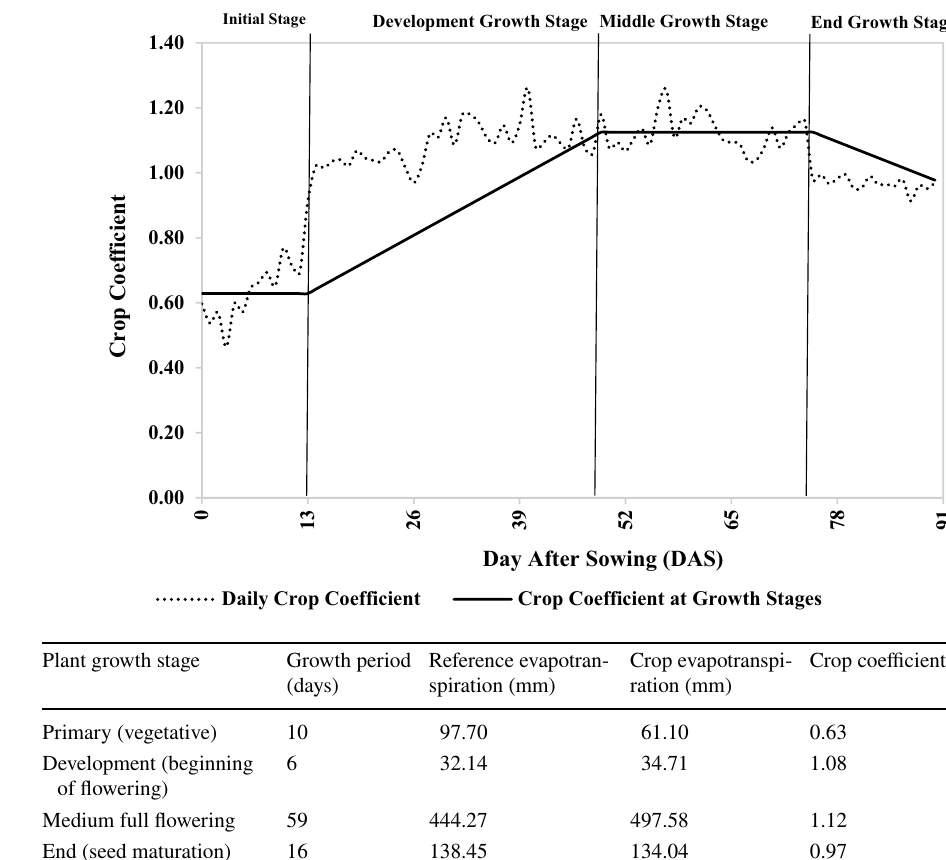
Fig. 6 The trend of plant coefficient changes during the growing season of basil